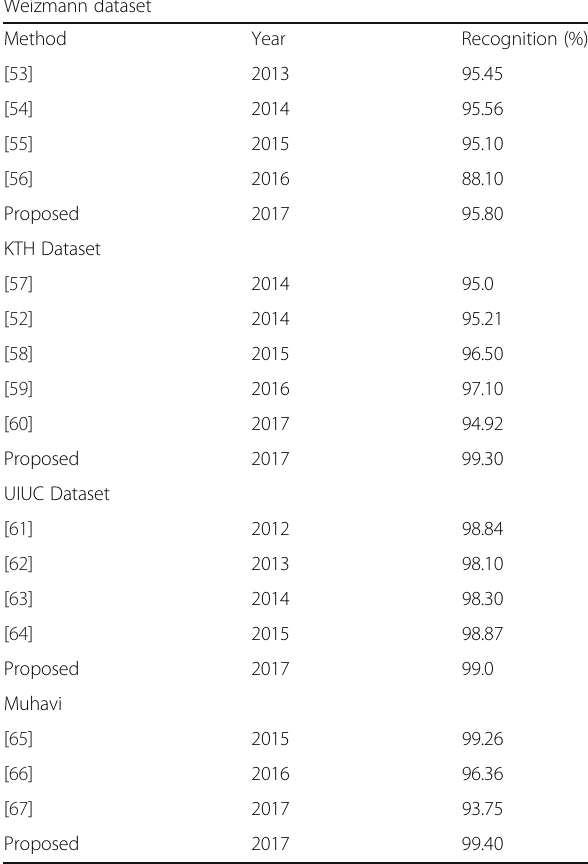
Table 14 Comparison of recognition